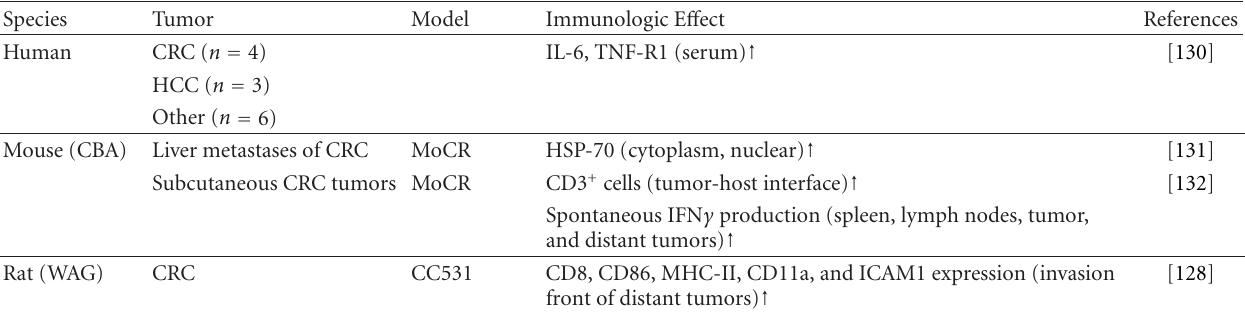
Table 6: Studies reporting immune modulation in cancer patients and animal models treated with